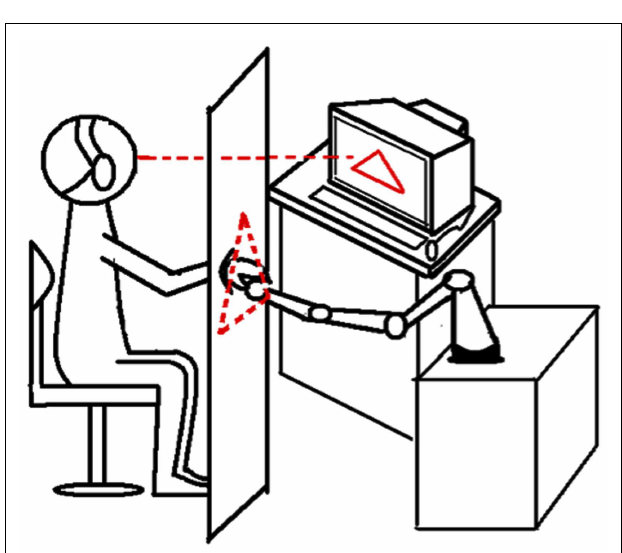
FIGURE 3 | Schematic view of the set-up. The participant is sitting in front of a curtain, putting her/his hand through it on a robot arm.With help of the robot, limb movements could be carried out passively or actively. A distorted visual feedback about the limb movement could be presented on a LCD monitor, left alongside the robot in front of the